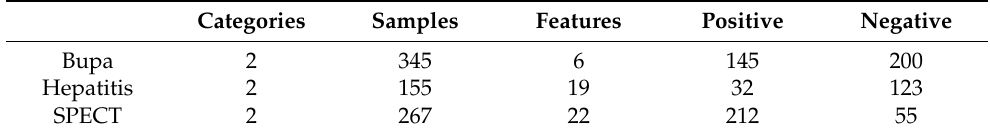
Table 1. The two-class-dataset-related information.